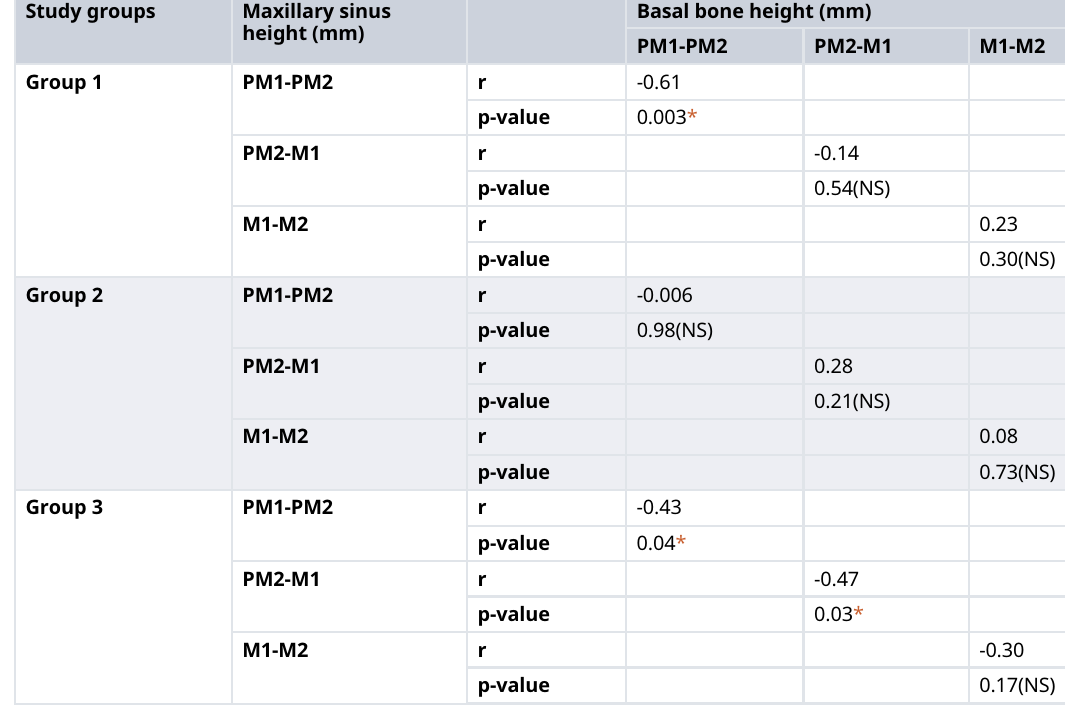
Table 4. Correlation between maxillary sinus height and Basal bone height in each study groups. Study